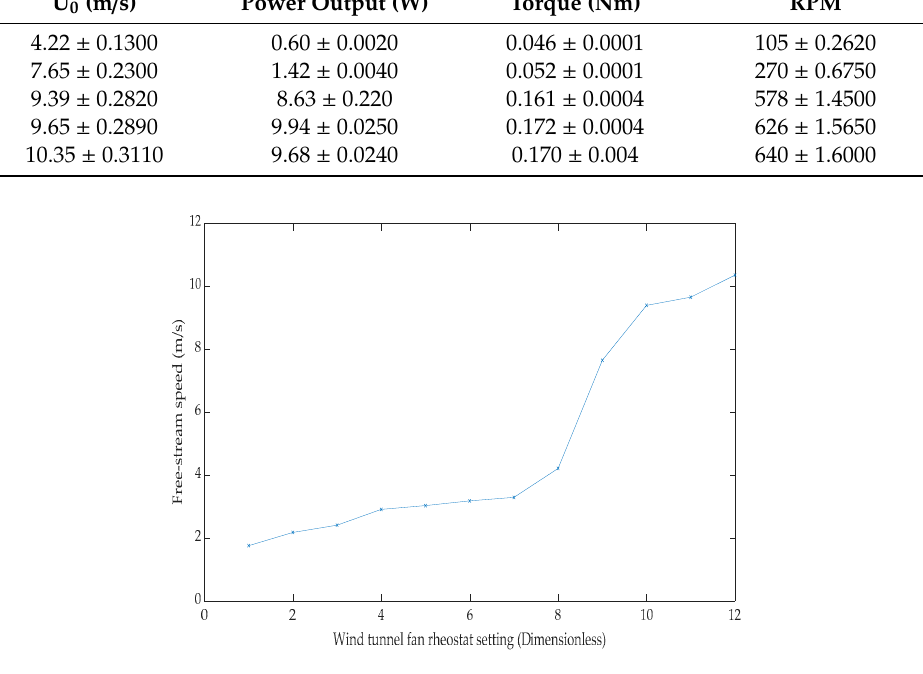
Figure 5. Wind tunnel fan calibration profile. Table 2. Estimates of the induction factor.